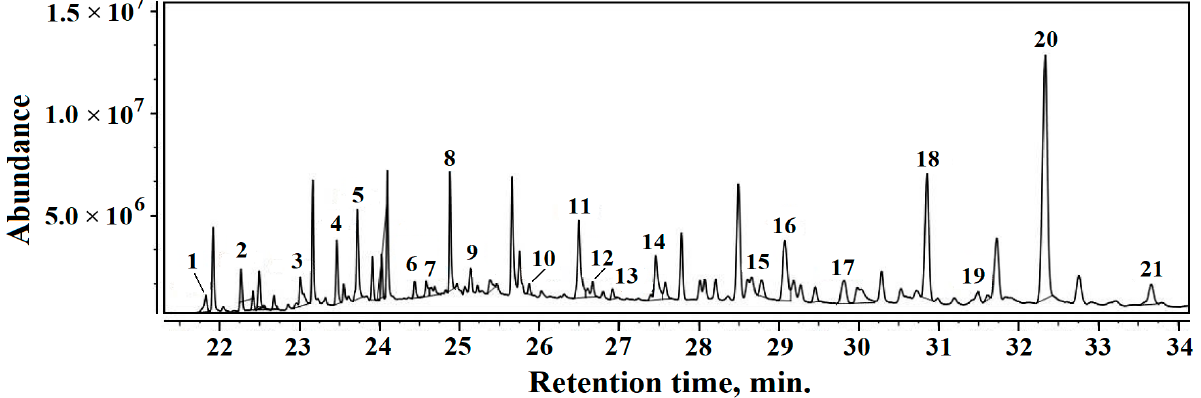
Figure 9. TIC chromatogram results for organic fraction within Sample 1.